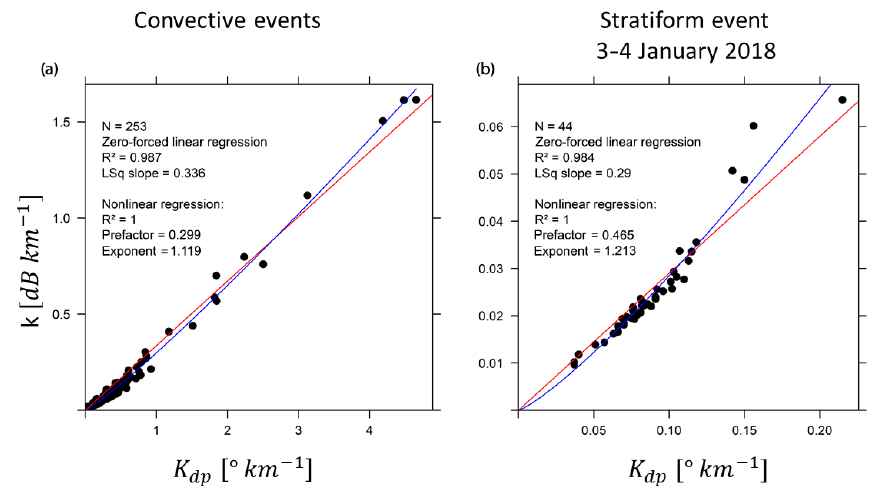
Figure 8. DSD-derived k – K dp relationships for the nine convective events (a) and for the stratiform event of 3–4 January 2018 (b) (see text for details).